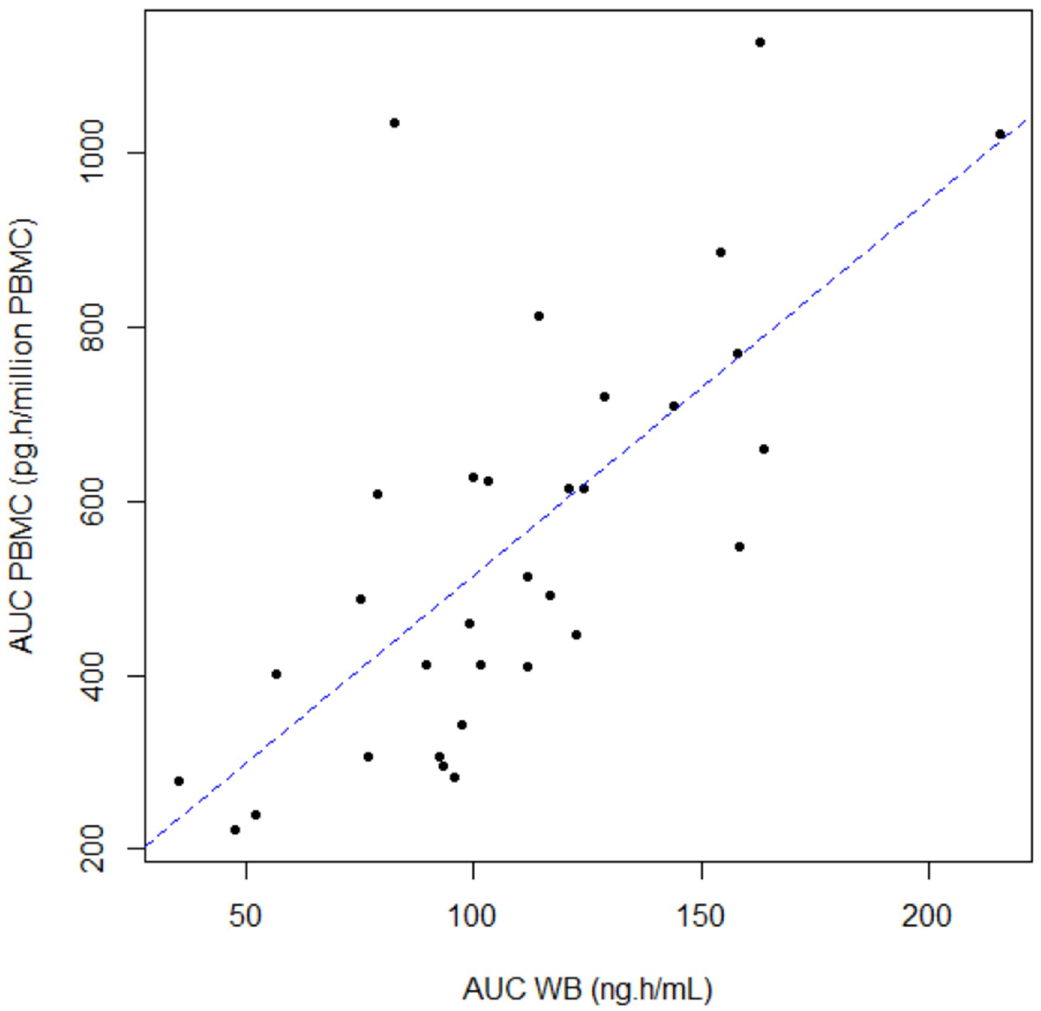
Fig 2. Relationship between area under the concentration–time curve from 0 to 12 h (AUC) of tacrolimus in whole blood (WB) and in peripheral mononuclear blood cells (PBMC). The dotted line is the linear regression curve. (n = 32) (r 2 = 0.51, p <